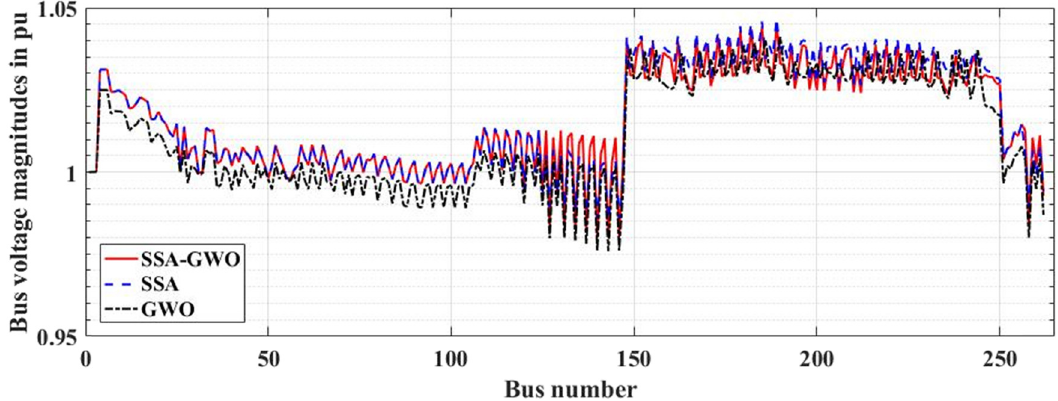
Figure 8: The voltage pro fi le with SSA, GWO, and SSA – GWO on the IEEE 123 - bus simulation system with fi ve DGs.